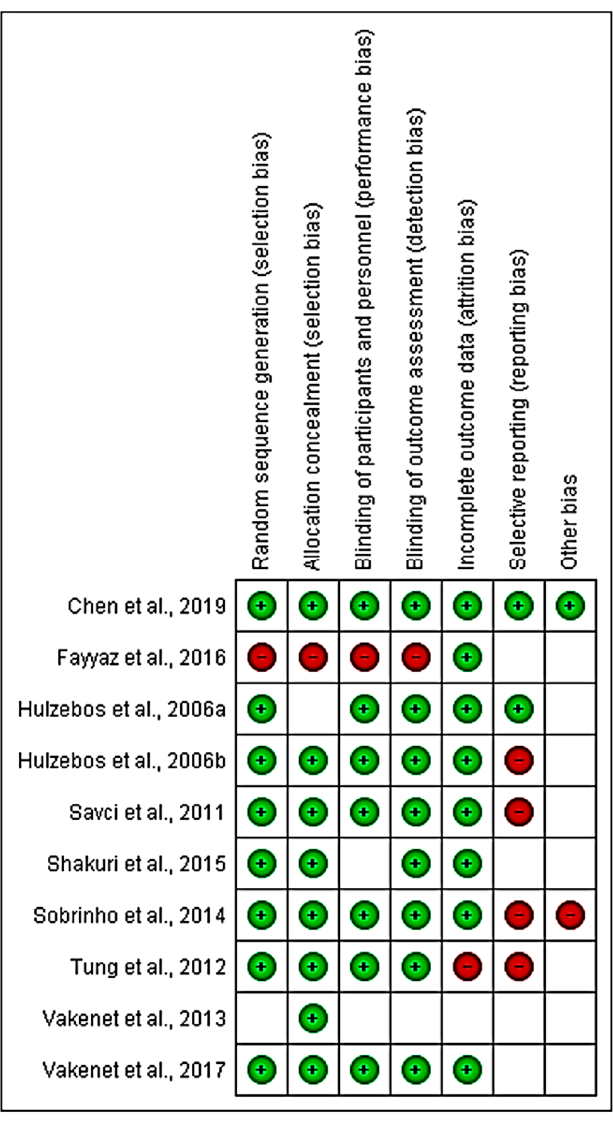
Figure 12. Risk of bias summary for the included studies. A square with a green circle means low risk, a square with a red circle means high risk, and an empty square indi- cates unclear risk.